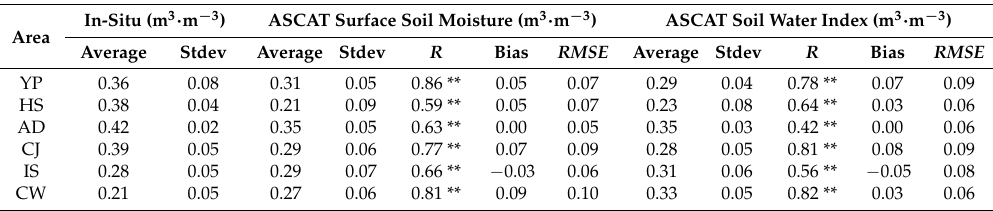
Table 3. Comparison of in situ data, ASCAT SSM, and ASCAT SWI ( T = 20) from 1 May to 30 September